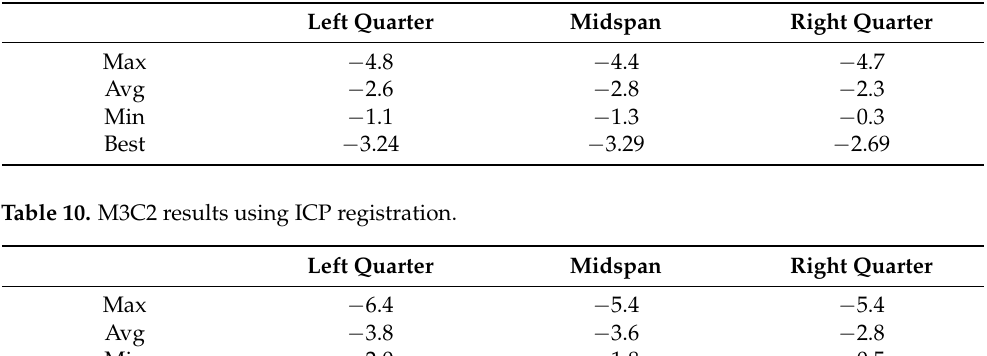
Table 9. C2C results using ICP registration.